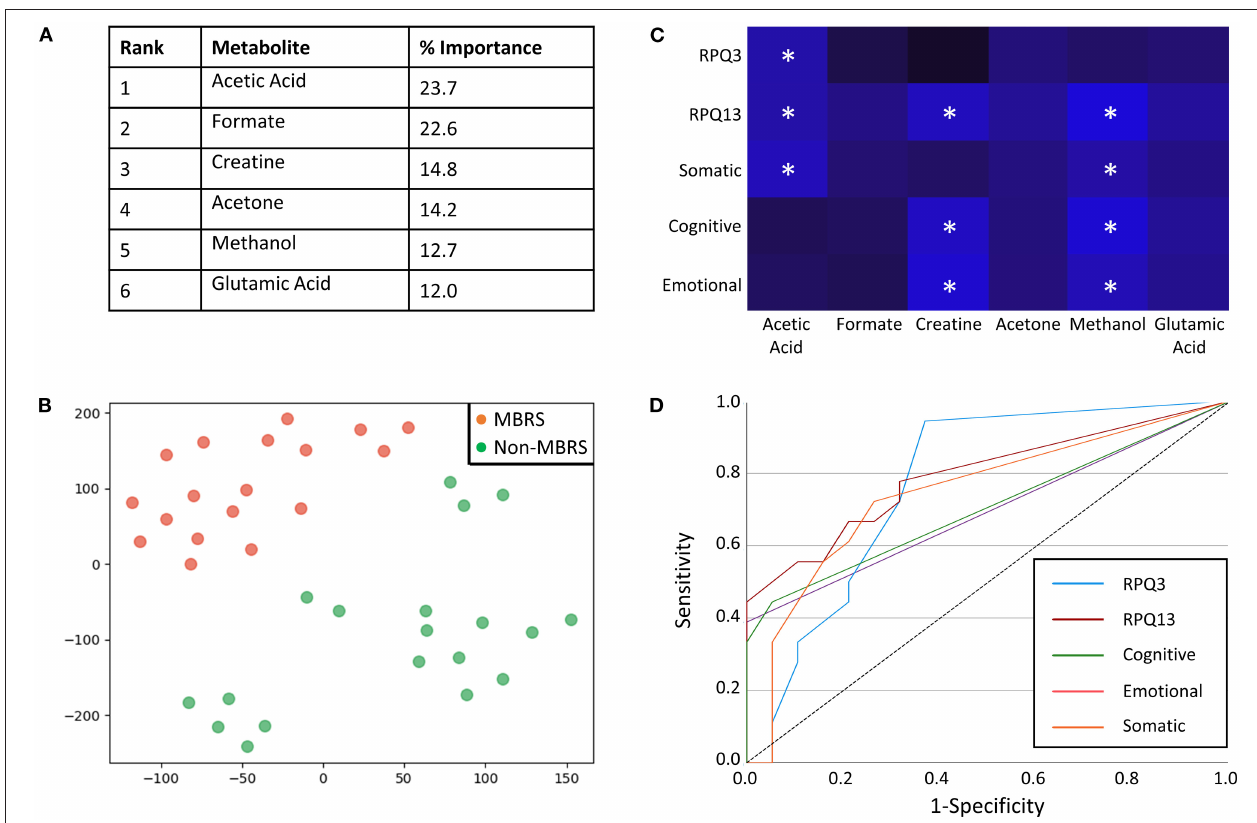
FIGURE 1 | Metabolites identified with feature selection that determine military breacher/range staff (MBRS) status and their relationship with Rivermead post-concussion variables. (A) A rank order of six leading plasma metabolites that classify MBRS vs. non-MBRS with 98% classification accuracy. All six metabolites are significantly decreased in plasma from MBRS when compared to non-MBRS. Their relative % importance is shown. (B) A tSNE plot demonstrating that MBRS and non-MBRS can be easily separated and identified based on plasma levels of the leading six metabolites. The axes are dimension-less. (C) A heat map demonstrating the negative correlations between Rivermead post-concussion variables and plasma levels of the six leading metabolites. Brighter blue represents a stronger negative correlation. Statistically significant negative correlations are indicated with white asterisks (* P < 0.05). (D) ROC curves illustrating that the Rivermead post-concussion variables are predictive of MBRS status, as well as with the metabolite parsimonious combinations listed in Table 4 [RPQ13 (late symptoms) AUC = 0.79 [0.65–0.94], RPQ3 (early symptoms) AUC = 0.77 [95%CI 0.62–0.93], Somatic AUC = 0.75 [95%CI 0.58–0.91], Cognitive AUC = 0.71 [95%CI 0.53–0.88], and Emotional AUC = 0.69 [95%CI 0.52–0.87].